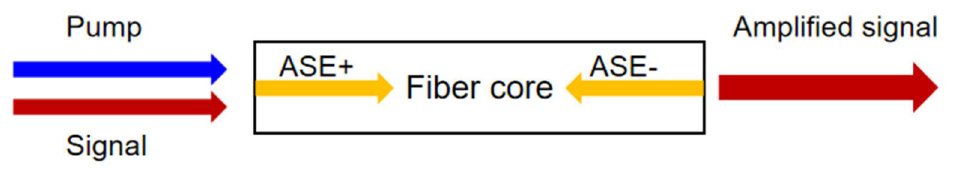
Figure 7. Propagation of the pump laser, signal laser and ASE in the Tm-doped fiber core. The 793 nm laser is used as the pump, the seed is injected into the thulium-doped fiber amplifier. The pump power starts at 10 W and increases to 50 W with a step length of 10 W. The relationship between the output power and the fiber length under different pump powers is shown in Figure 8.